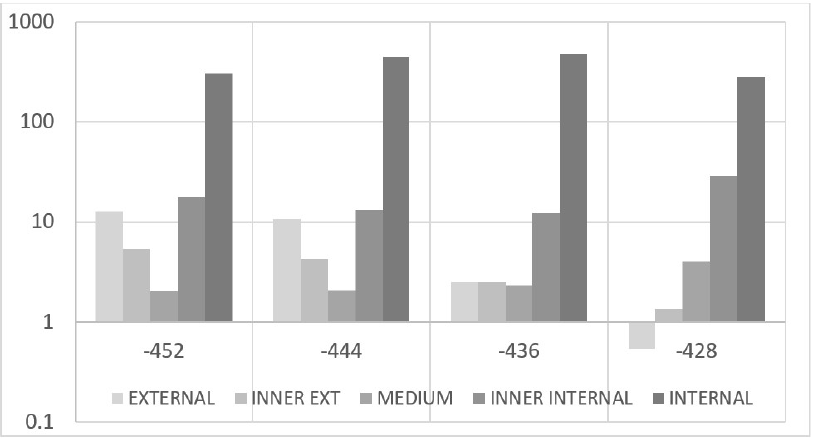
Figure 28. Histogram representation, in a logarithmic scale, of the strain difference, measured by the same optical fiber as the flaw is moved from one side to the other of the cap. Reported values refer to four different abscissas, spanwise, in the region of the max difference (internal fiber, Figure 26).